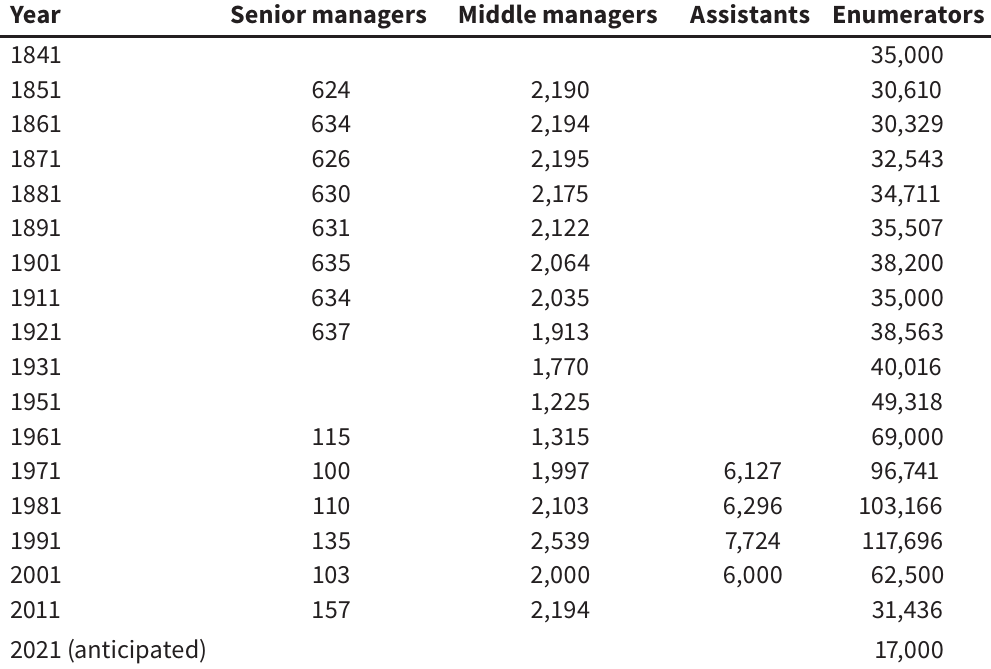
England and Wales Census